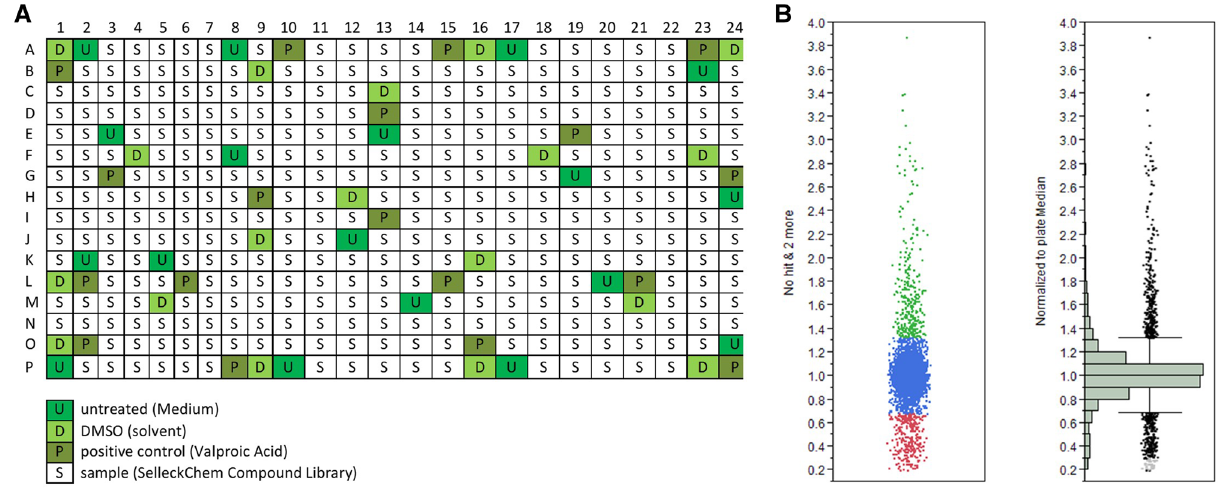
Figure 2. Plate layout and quality control of the luciferase reporter drug screening assay. ( A ) Plate layout of randomly distributed drugs and controls. ( B ) Threshold for hit definition: compounds were considered as effective when showing a difference beyond the four-fold standard deviation (4 × SD = 0.33) compared to untreated